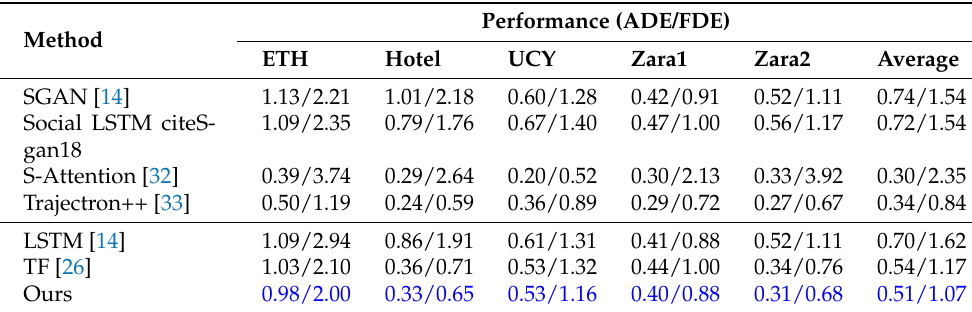
Table 2. Result comparison with the state of the art methods on ETH and UCY datasets following the single trajectory deterministic protocol. The social-based and individual-based methods are shown in the top and bottom parts of the table, respectively. We achieve the best performance in the individual version.